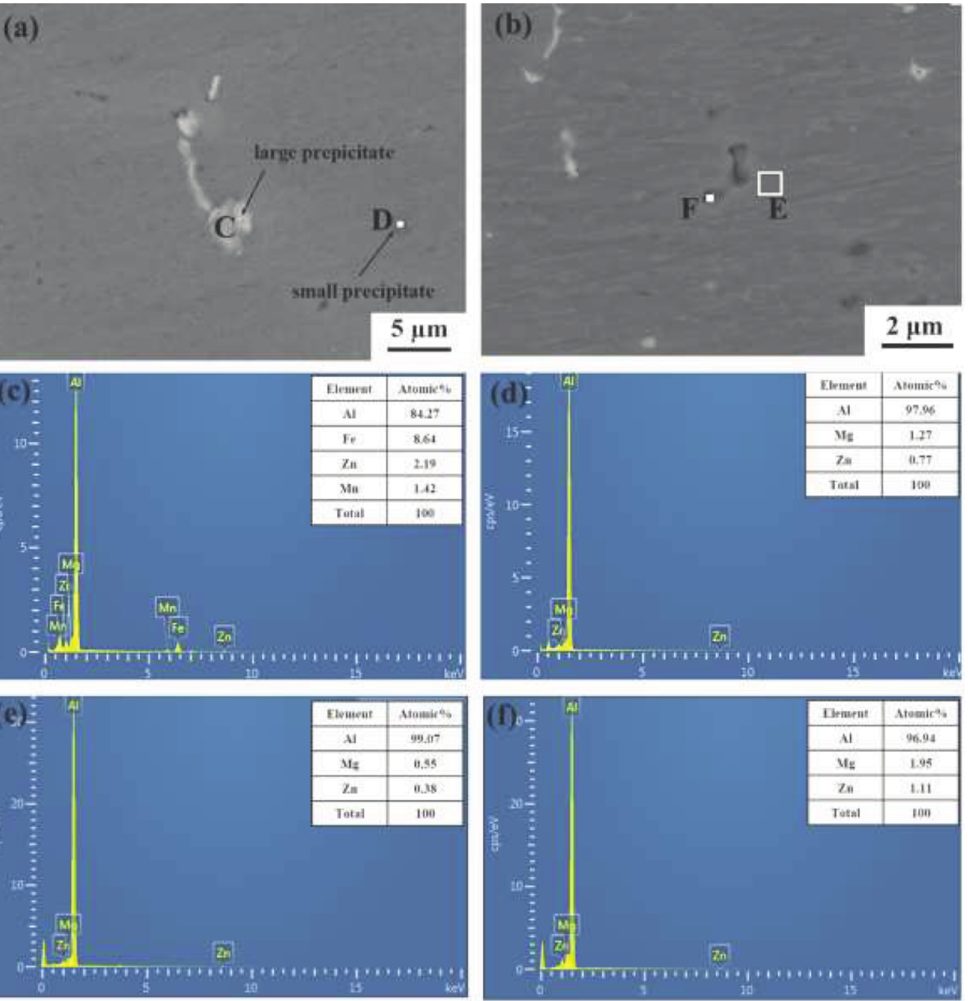
Figure 7: Images of SEM and EDS analysis: (a) detail of WZ in a DWMW joint; (b) typical EDS analysis of the large precipitate and (c) typical EDS analysis of the small percipitate.